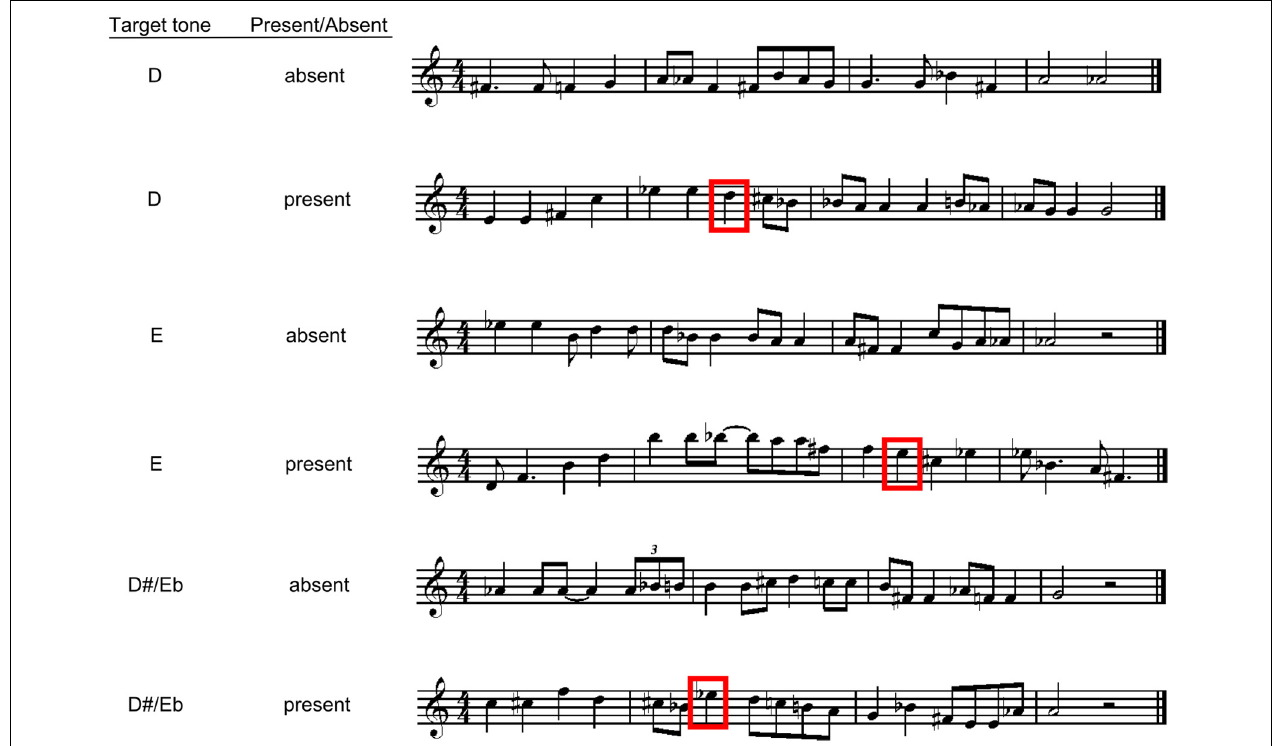
FIGURE 5 | Examples of experimental stimuli for Experiment 3. The boxes indicate present targets.